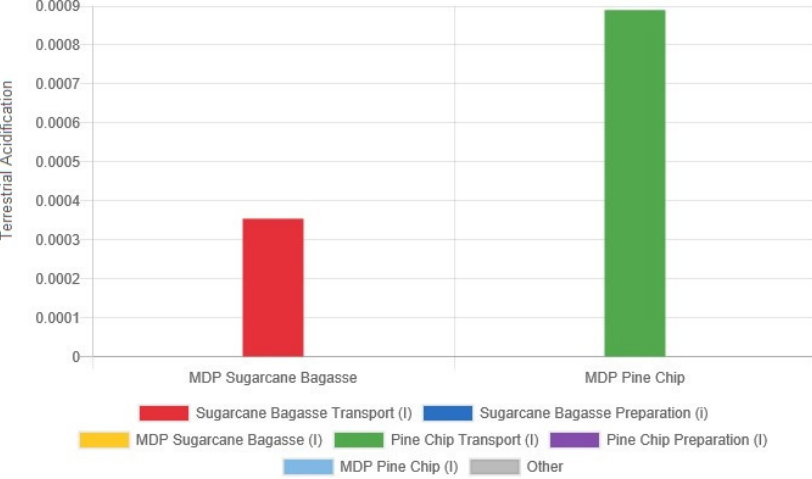
Figure 7. Impacts of terrestrial acidi fi cation (kg SO 2 eq).